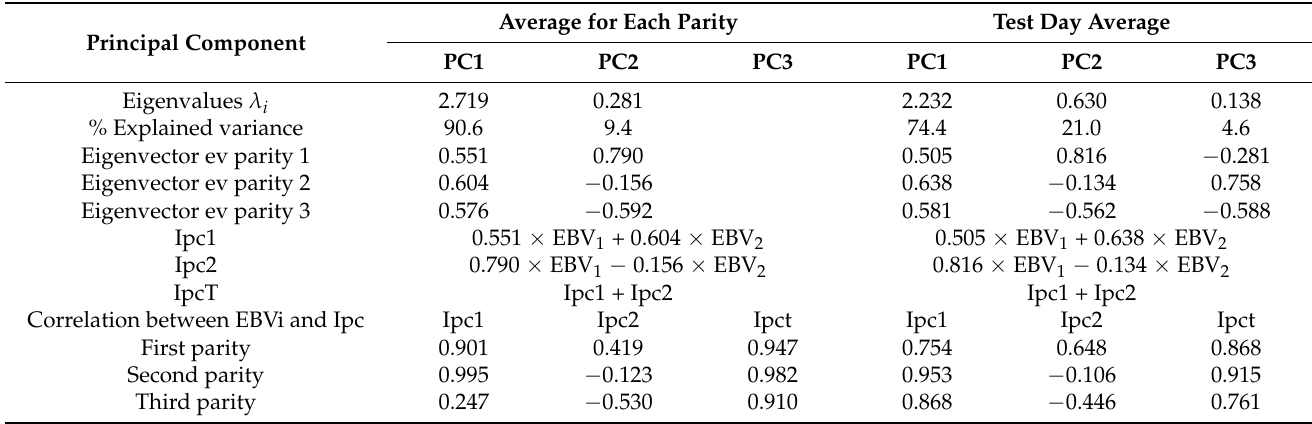
Table 5. Results of principal component analysis, the conformation of index (Ipc) and correlations between Ipc and original breeding values for each parity.